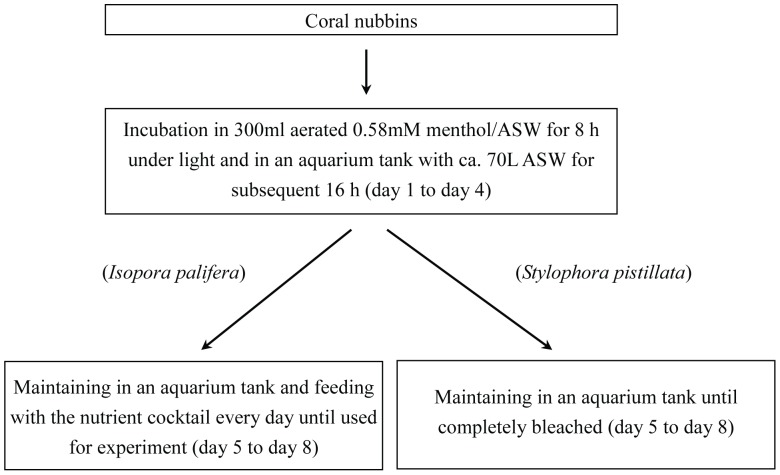
Flow diagram of the preparation of aposymbiotic Isopora palifera and Stylophora pistillata.